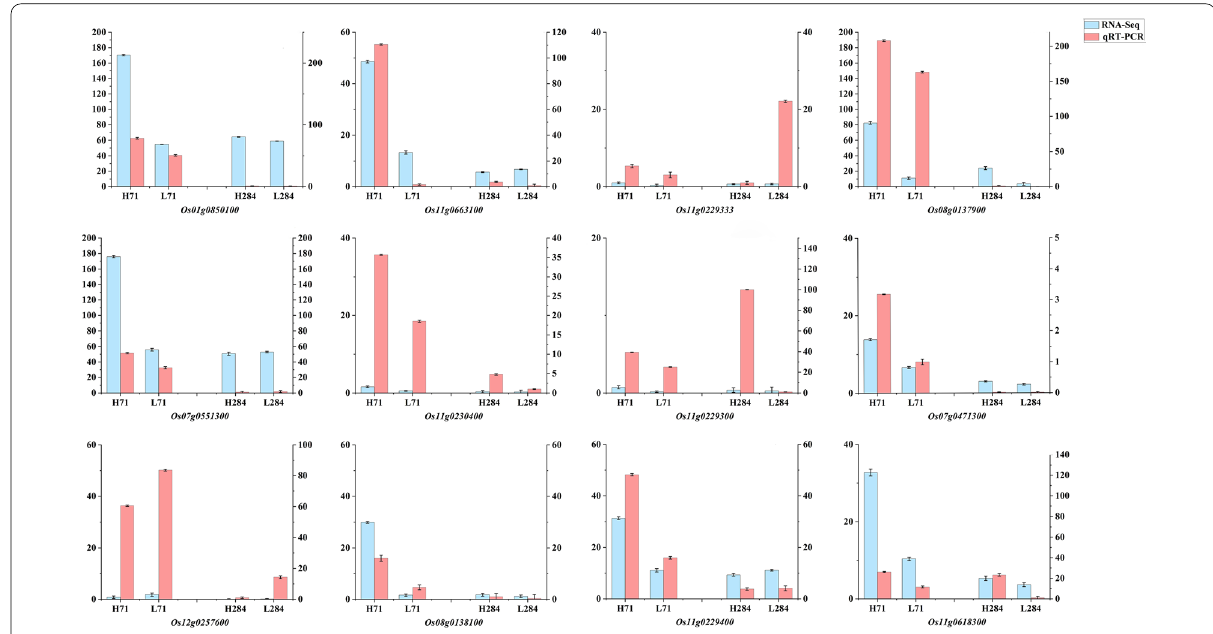
Fig. 6 qRT-PCR analysis of gene expression levels. H71: Longjing 31 under high-nitrogen treatment. L71: Longjing 31 under low-nitrogen treatment. H284: Songjing 10 under high-nitrogen treatment. L284: Songjing 10 under low-nitrogen treatment